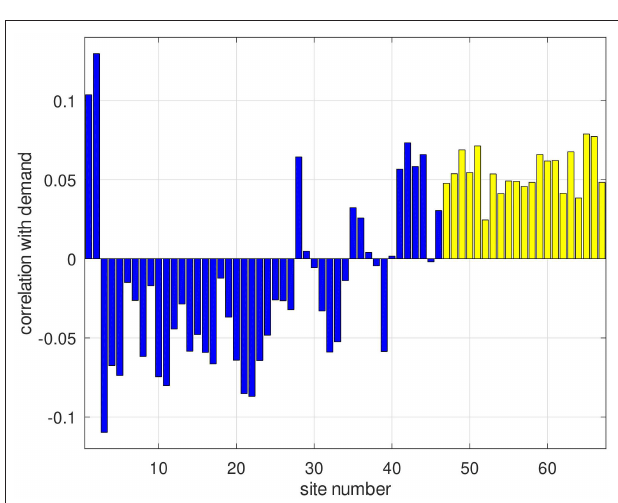
FIGURE 6 | Hourly correlation between electricity load and capacity factor time series (blue bars for wind sites; yellow bars for solar sites). For site reference see Tables S2 , S3